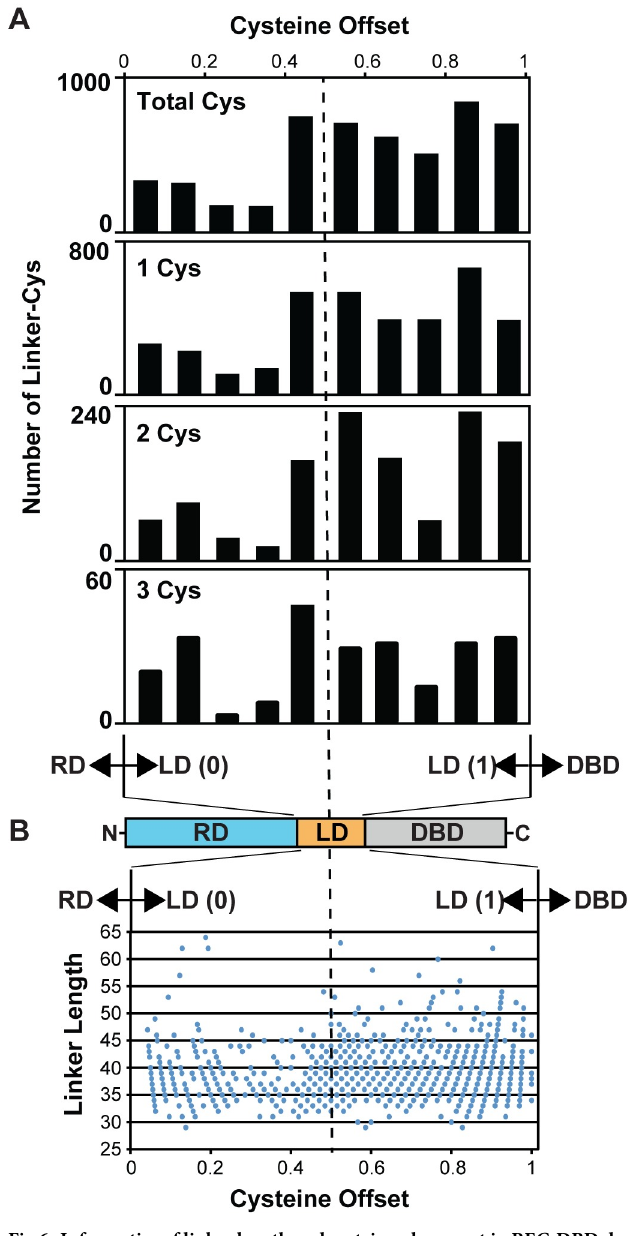
Fig 6. Informatics of linker length and cysteine placement in REC-DBD domain architectures. ( A ) Bar graphs showing the number of single, double, triple and total cysteines found within block regions of the defined linker domain. Notice the obvious weighting to the linker C-terminus, closer to the effector DNA-binding domains. ( B ) Linker length versus cysteine placement plot from sequences where the linker contains only one cysteine. RD, regulatory domain; LD; linker domain; DBD, DNA-binding domain. The x-axis “cysteine offset” refers to cysteine placement from the N-terminus on the predicted linker (designated as “0”) and the C-terminus of the linker (designated as “1”). The center (0.5) of the predicted linker domains are designated by the vertical dotted line.